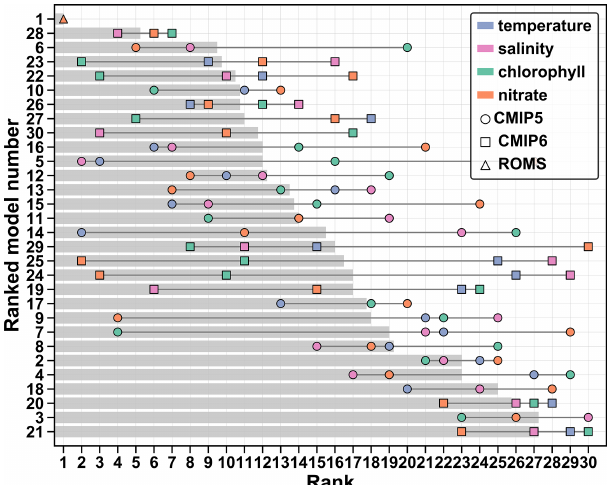
Figure 8. Model average (gray bars) and specific (dots) ranking. The final ranking is shown on the y axis. Hidden coinciding ranks (models 2, 3, 6, 10, 11, 18, 27, 28 and 30) are provided in Table 2.